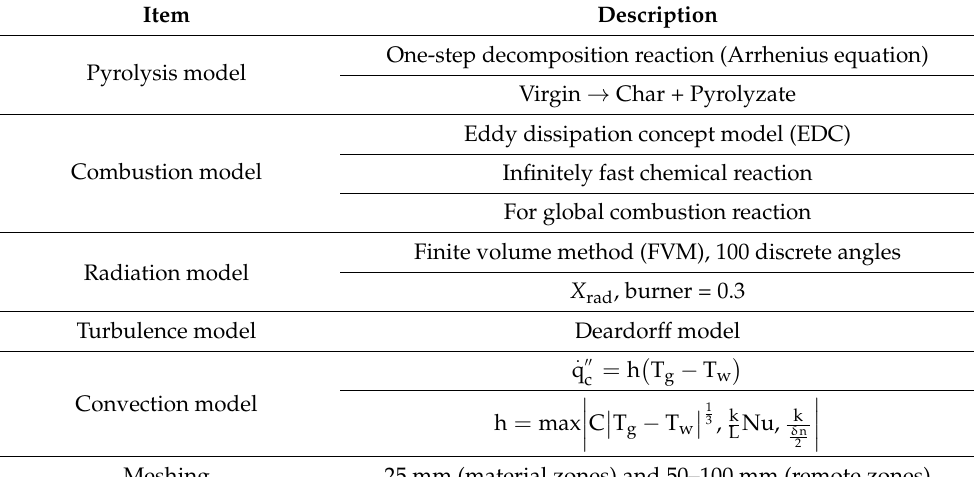
Table 1. Different sub-models and meshes used in the FDS of the ACP cladding